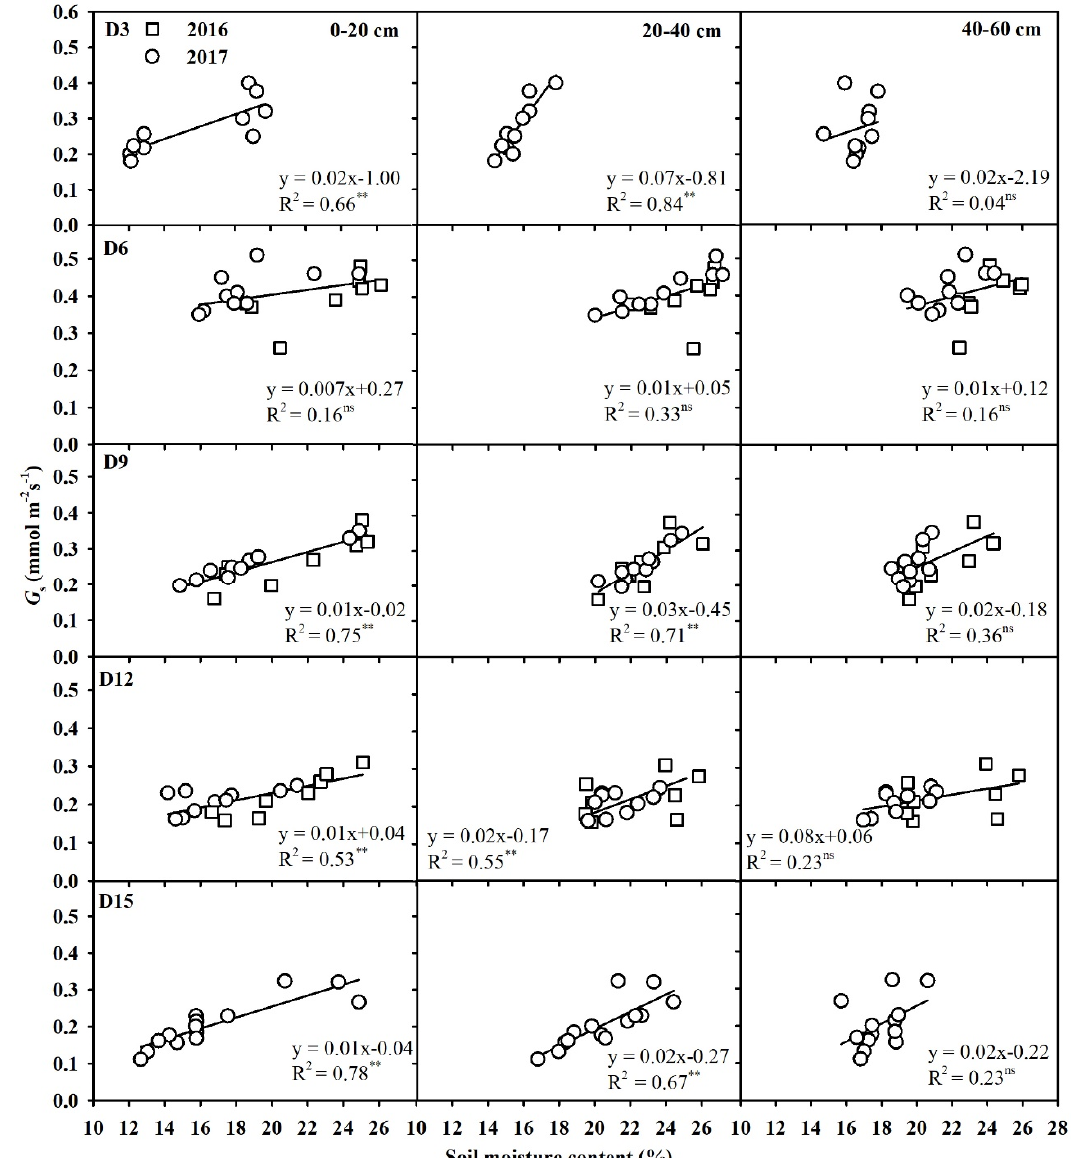
Figure 6. The relationship between soil moisture and stomatal conductance ( G S ) in different soil layers at different irrigation intervals. ** significant at 0.01 level; ns—not significant at